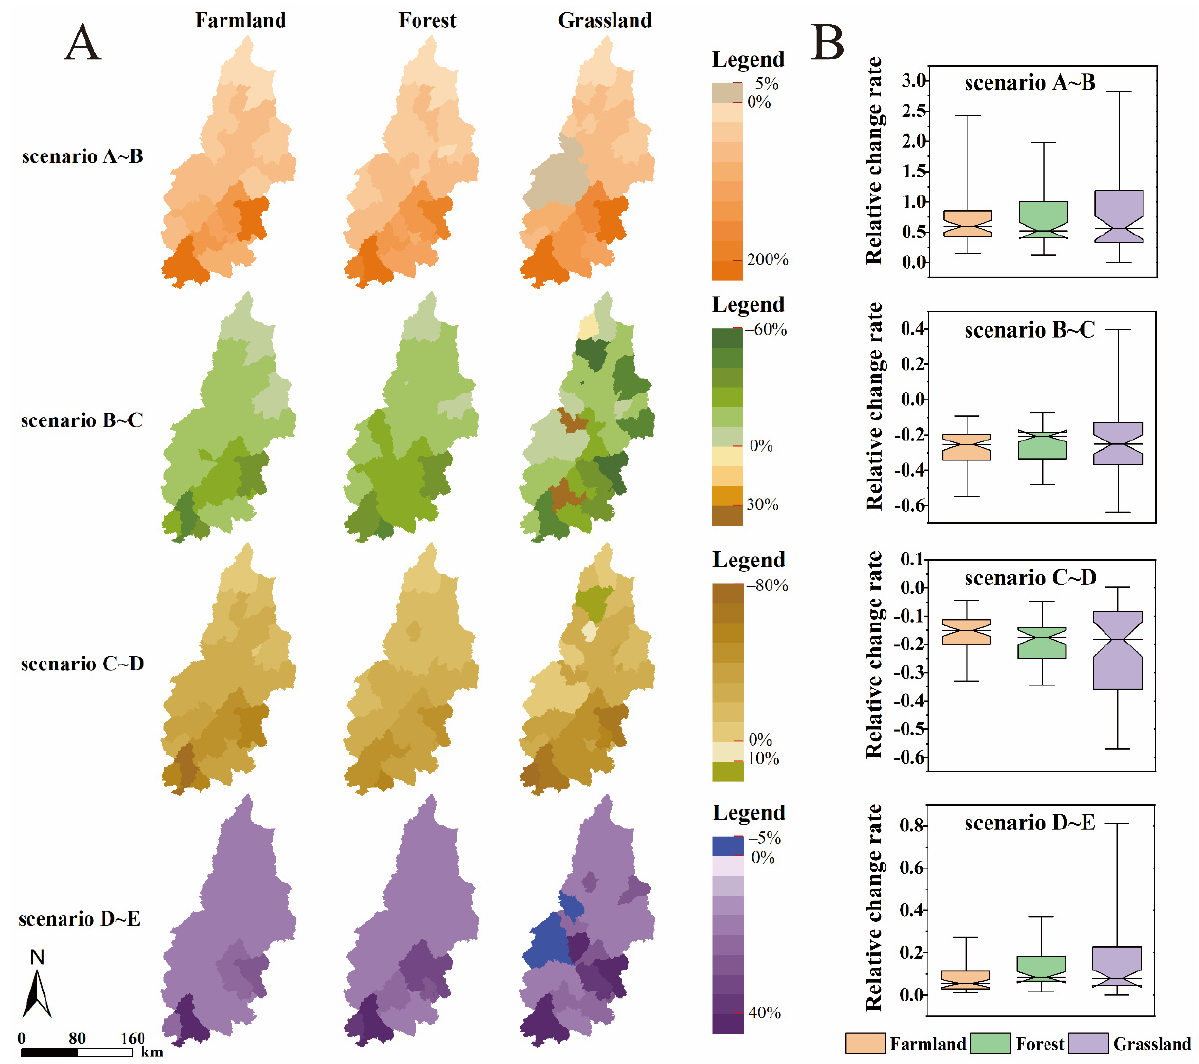
Figure 5. Relative change in WCA of each ecosystem under land use change scenarios (dry season). each